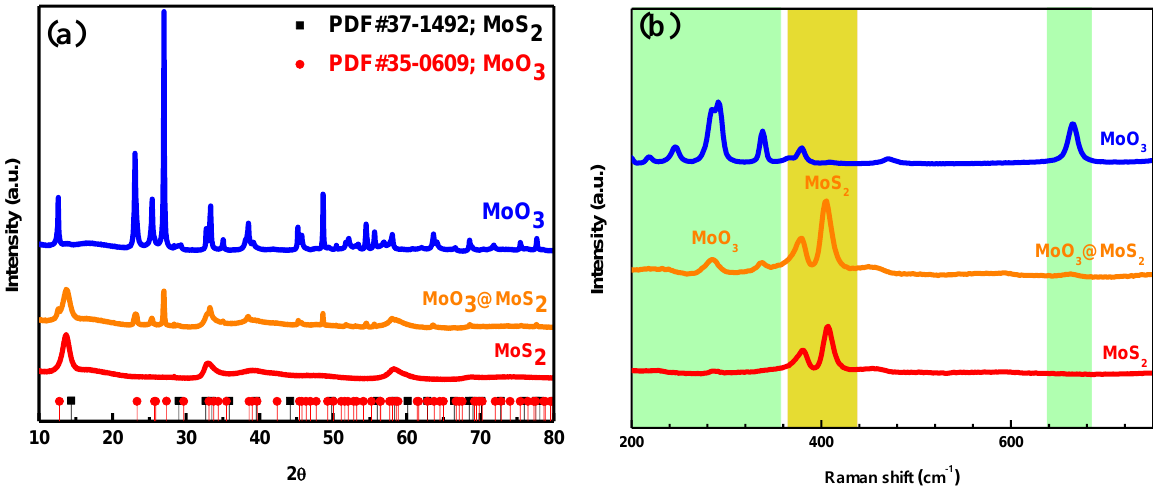
Figure 2. ( a ) HRPD and ( b ) Raman spectra of MoS 2 , MoO 3 @MoS 2 , and MoO 3 .